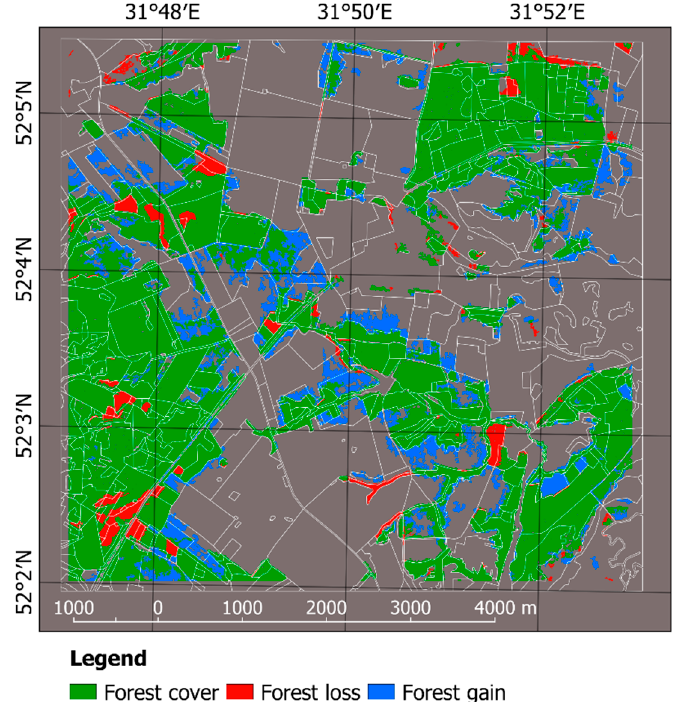
Figure A2. Temporal changes in forest cover within the study area mapped for the time period of 2010–2015 using RapidEye and SPOT 6 satellite images. The loss addresses to harvest and natural disturbances occurred in forest ecosystems since 2010. The gain represents planting regeneration on clear cuts and natural successions on preliminary unforested in 2010 areas.